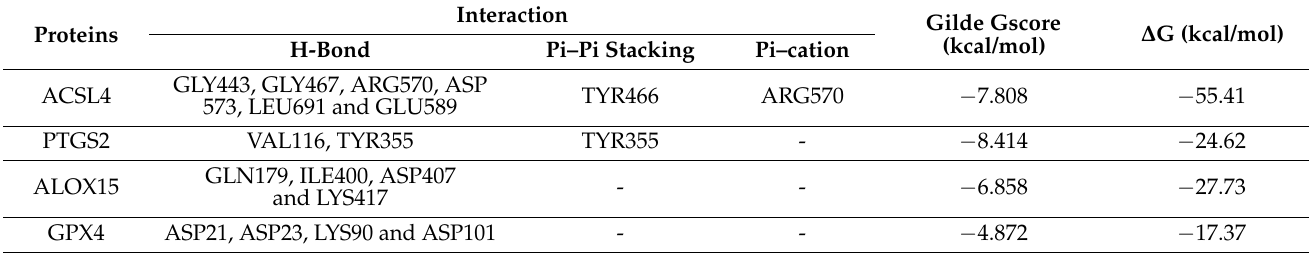
Table 2. The scores of Gilde docking and binding free